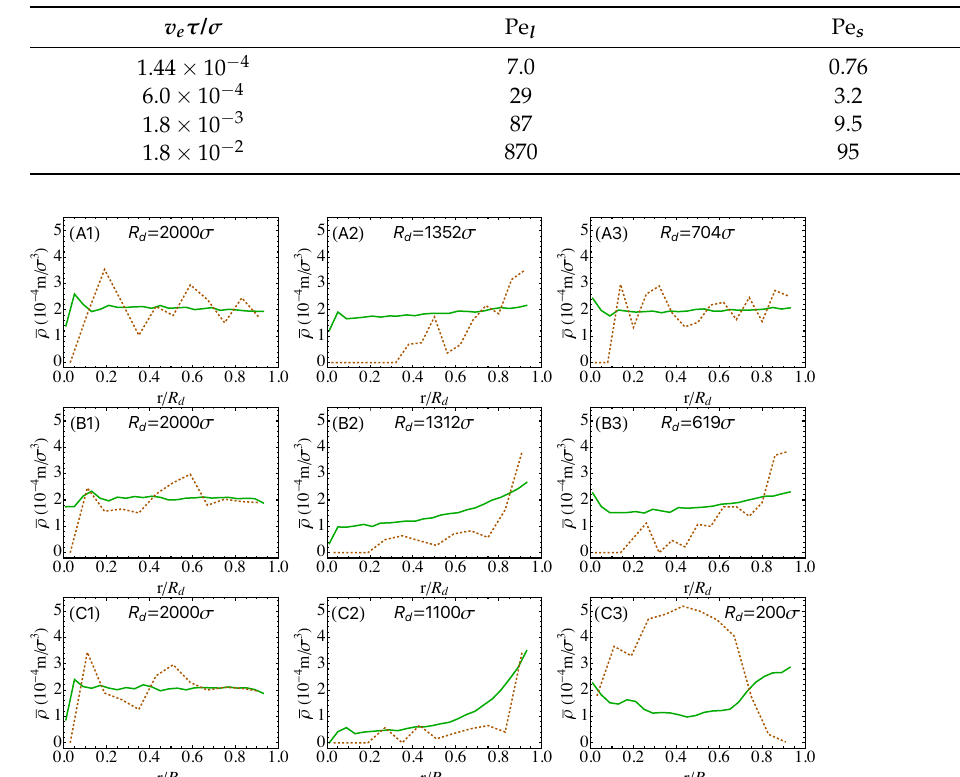
Table 2. Péclet numbers for LNPs and SNPs in their mixtures.